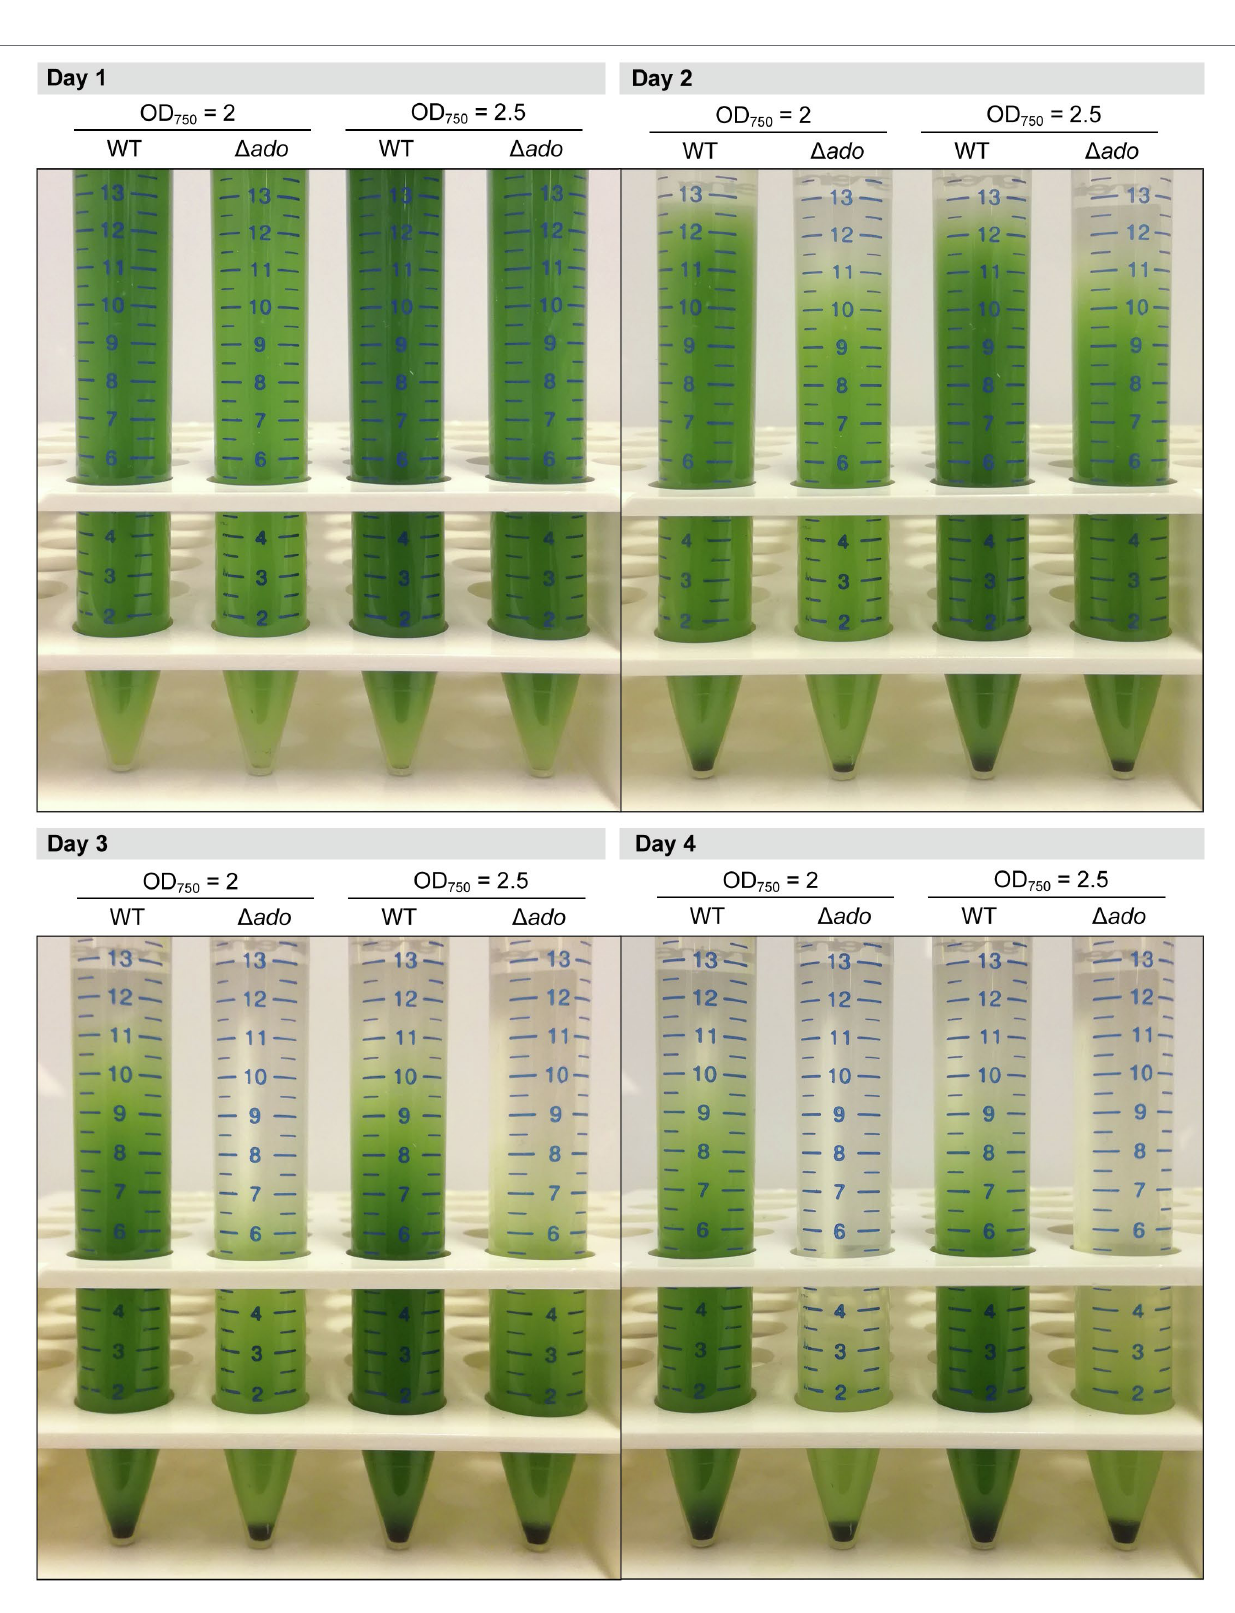
FIGURE 4 | Comparison of static gravitational sedimentation between Synechocystis sp. PCC 6803 Δ ado and WT strains at optical cell density (OD 750 ) 2.0 and 2.5. The pictures were taken on subsequent days 1–4. For the experiment, the cells were cultivated at 30 ° C and atmospheric CO 2